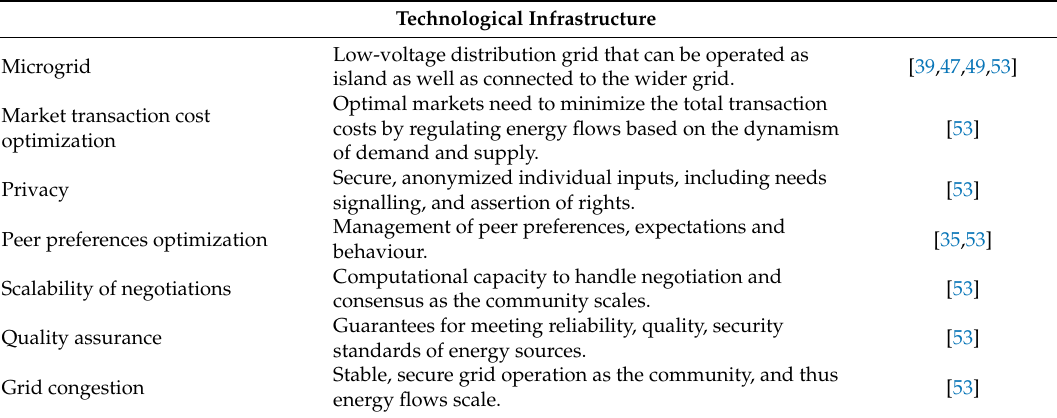
Table 5. Progression factors stemming from technological